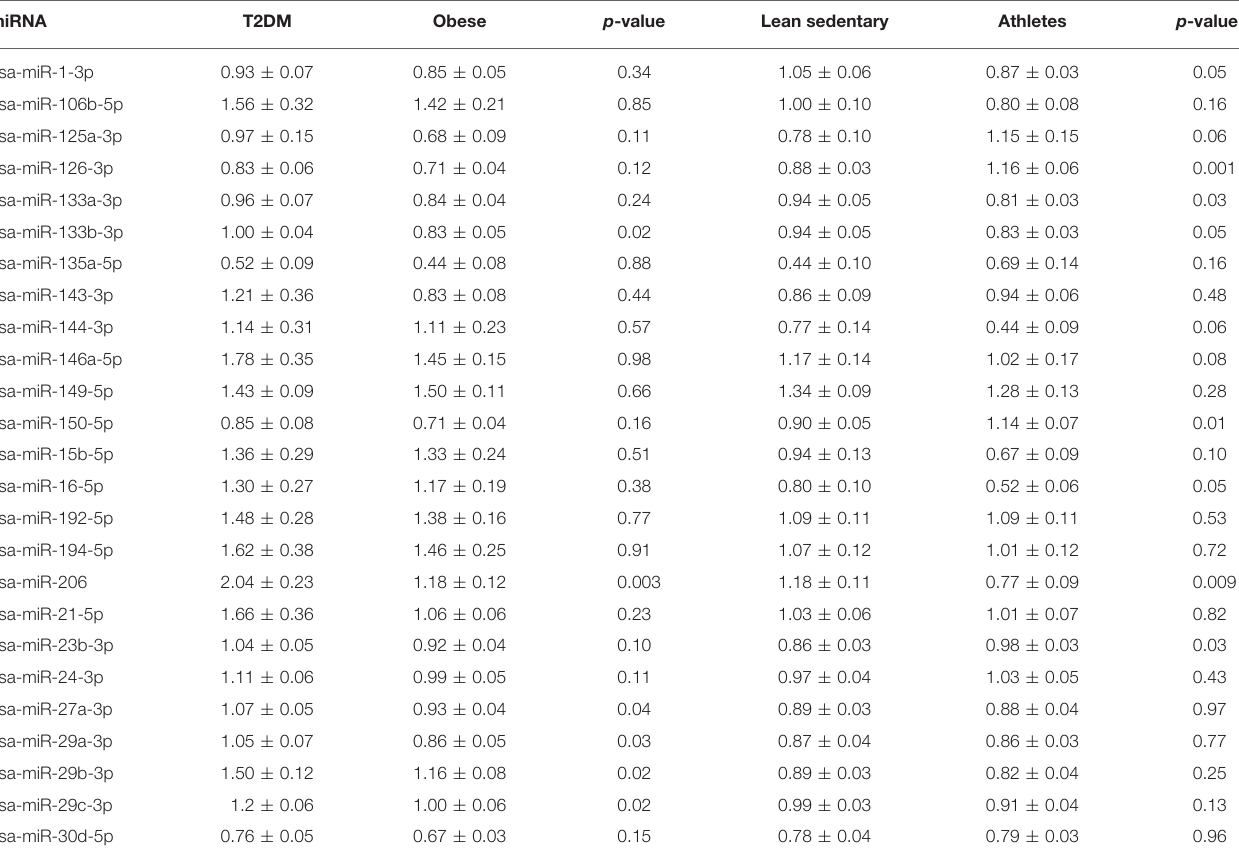
TABLE 4 | List of relative miRNA expressions in type 2 diabetic patients (T2DM) vs. non-diabetic overweight/obese individuals and lean sedentary individuals vs. endurance-trained athletes. miRNA T2DM Obese p -value Lean sedentary Athletes p -value